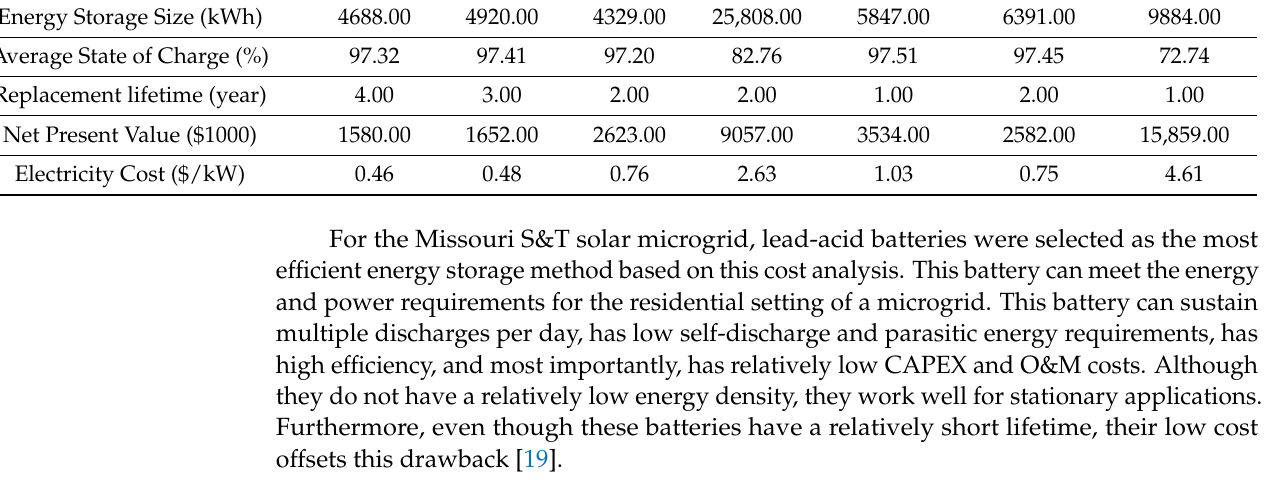
Table 3. Electric power production cost for various energy storage Table 2. Economic factors for energy storage technology considered in this study.